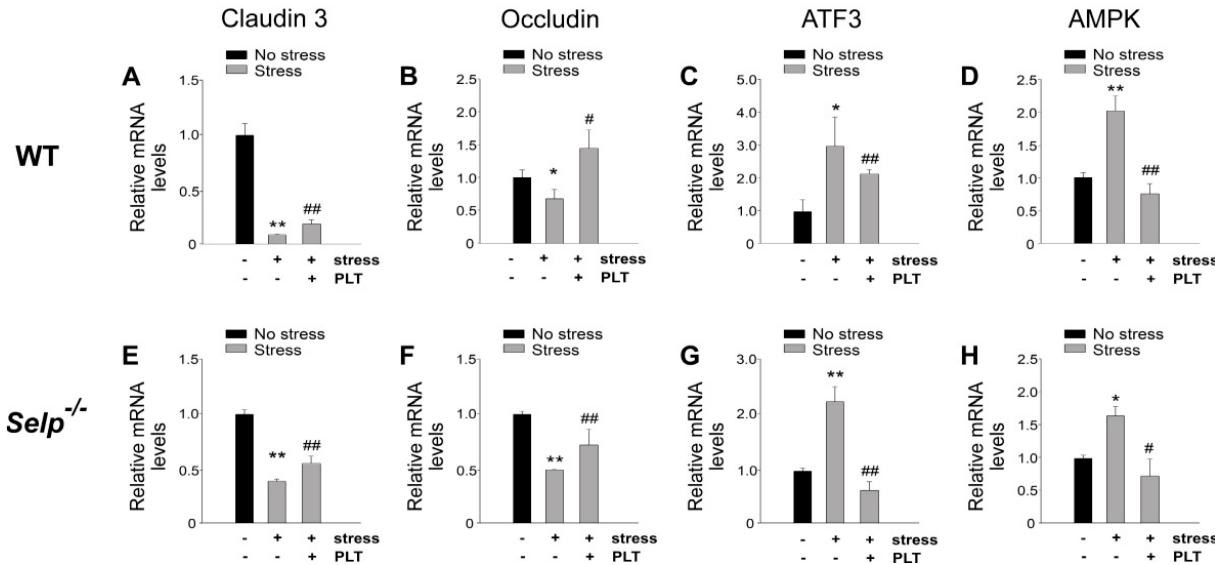
Figure 6. Relative mRNA expression levels of tight junction and stress-induced genes. Through qRT-PCR analysis, the relative mRNA expression levels of tight junction (CLDN3 and OLCN) (A, B, E, F) and stress-induced (ATF3 and AMPK) (C, D, G, H) genes, of wild type (WT; Selp +/+ ) (A-D) and P-selectin-deficient ( Selp − / − ) (E-H) mice in the duodenum with or without 9 h of restraint stress.